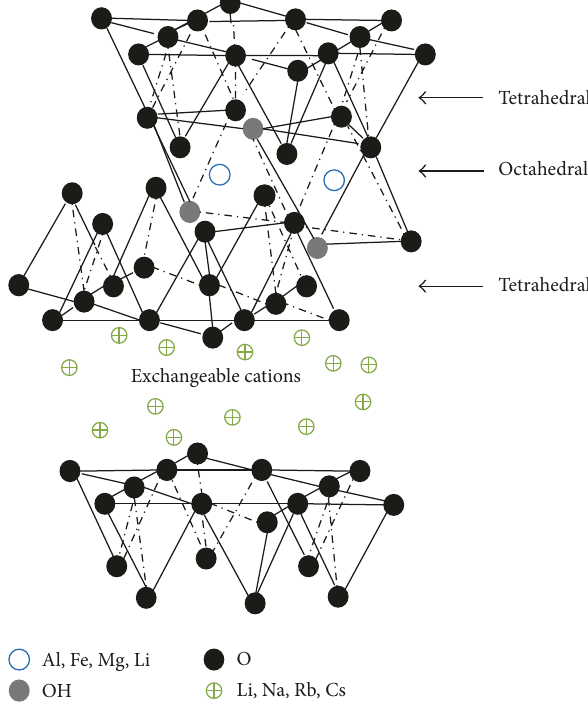
Figure 2: The molecule structure of MMT [34].